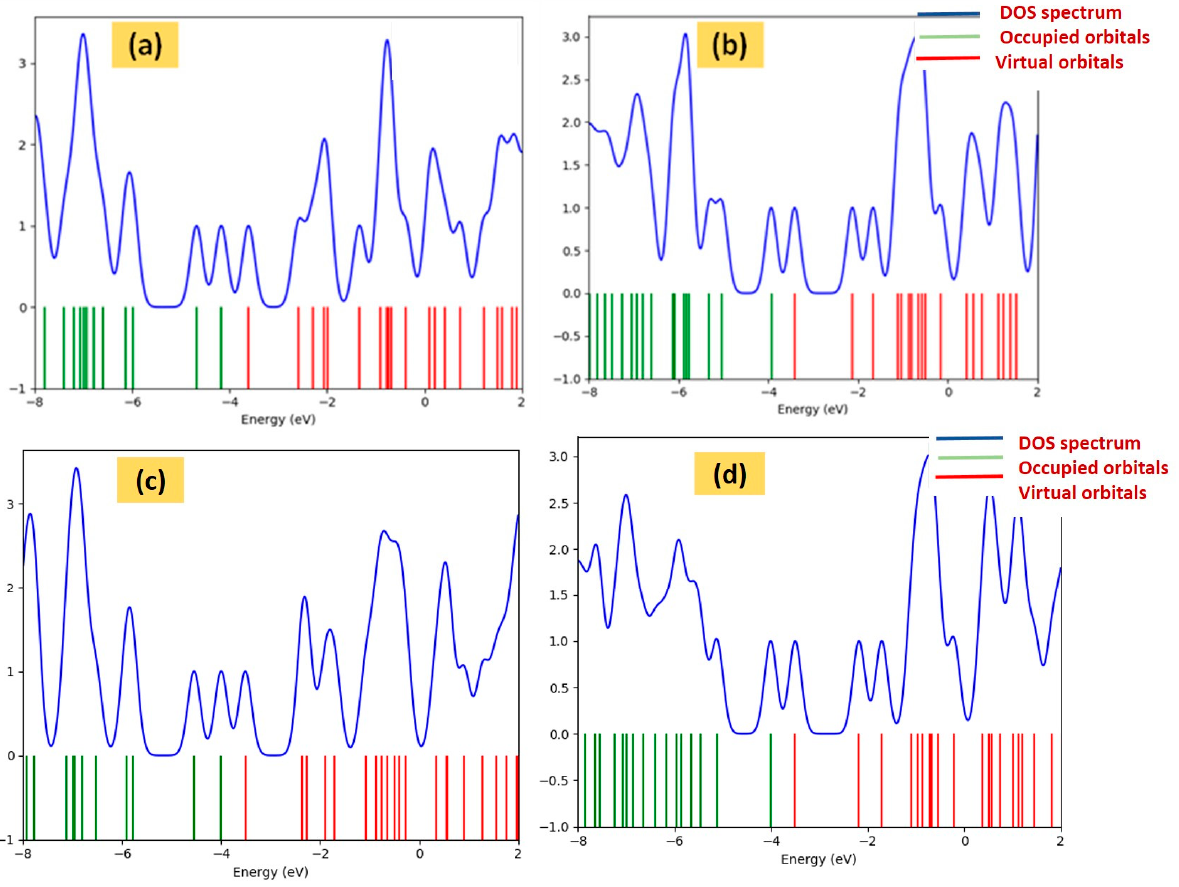
Figure 5. DOS plots shown in ( a , c ) for Pd doped graphene and ( b , d ) for Pd decorated graphene before and after adsorption of H2. Blue color indicates the DOS spectrum, green color indicates occupied orbitals and red color indicates virtual